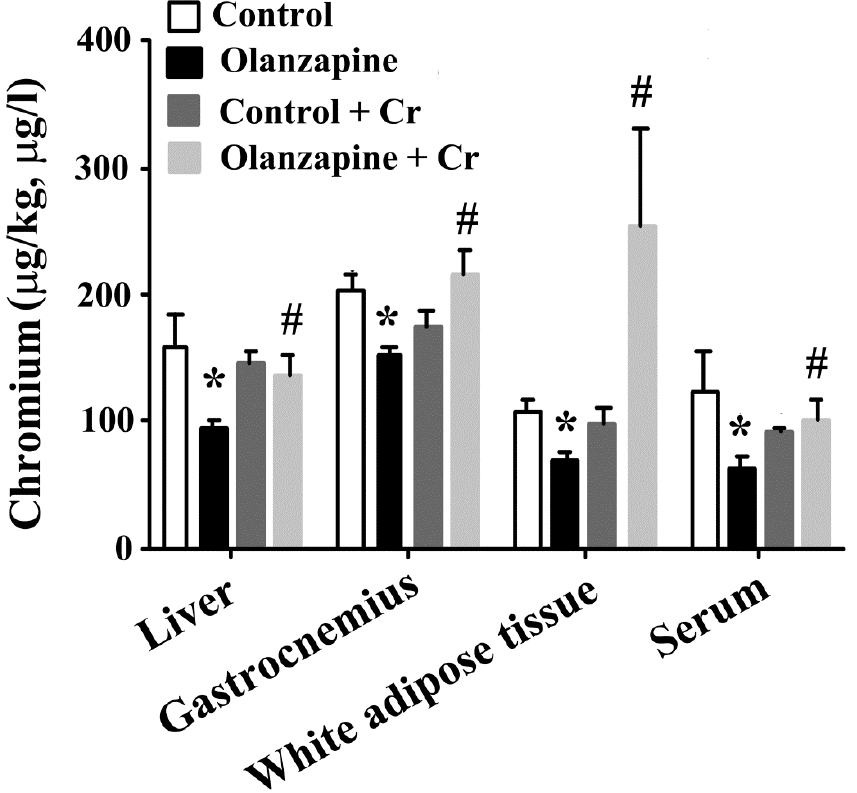
Figure 4. Chromium improved olanzapine-induced tissue chromium mobilization. At the end of the experiments, the excised liver ( µ g/kg), gastrocnemius ( µ g/kg), white adipose tissues (including inguinal, periovarian, mesentery, and perirenal fat) ( µ g/kg), and serum ( µ g/L) samples were subjected to analyses for the measurement of chromium content. * p < 0.05 vs. control and # p < 0.05 vs. olanzapine control, n = 10.